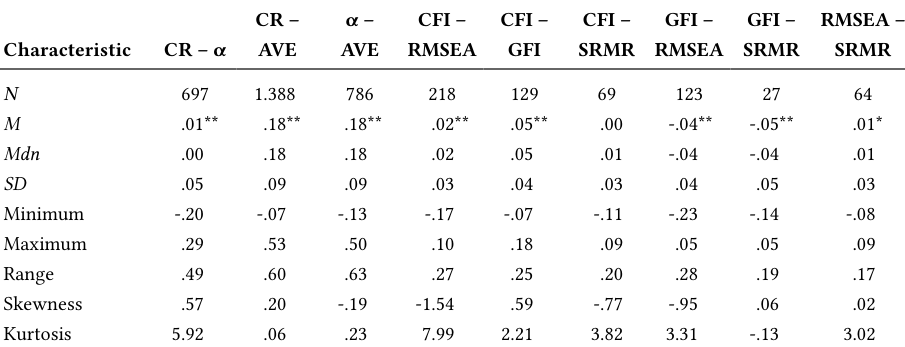
Descriptive Statistics of Differences Among Reliability Indices and Model Fit Metrics